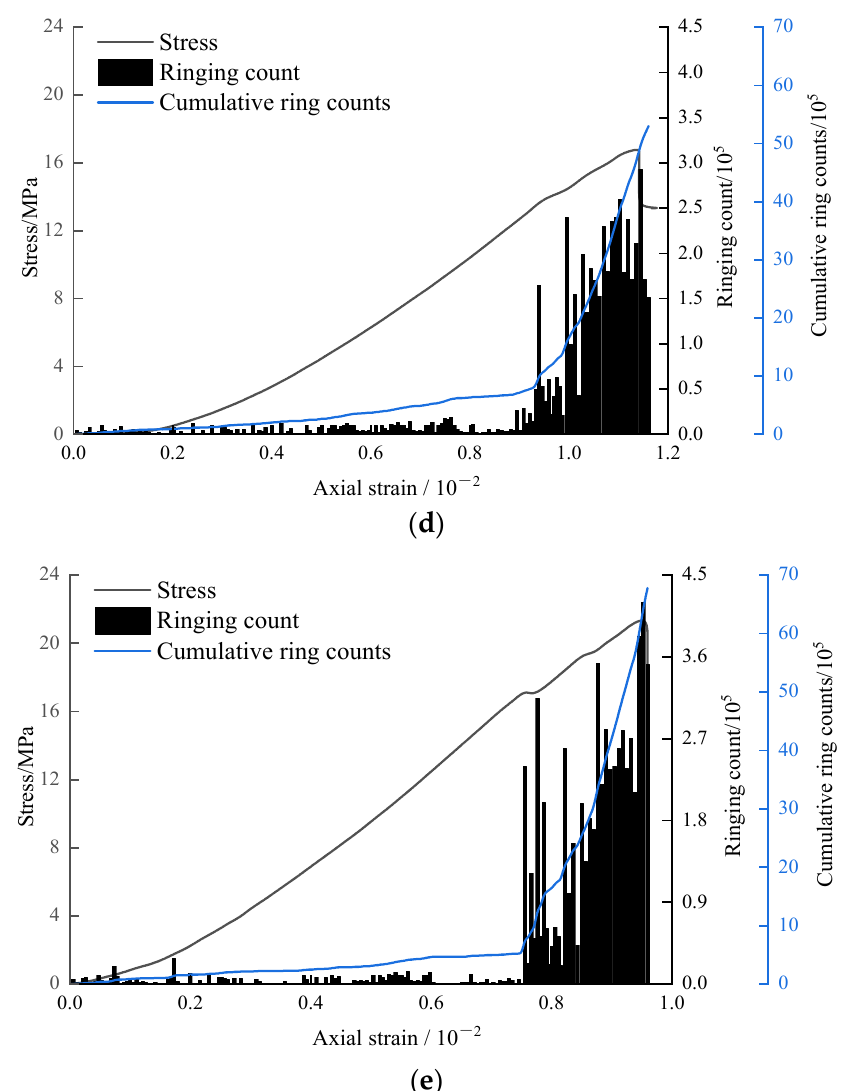
Figure 6. Variation Characteristics of AE parameters of coal samples under different loading rates: ( a ) V = 0.002 mm/s ( b ) V = 0.006 mm/s ( c ) V = 0.01 mm/s ( d ) V = 0.014 mm/s ( e ) V = 0.018 mm/s.